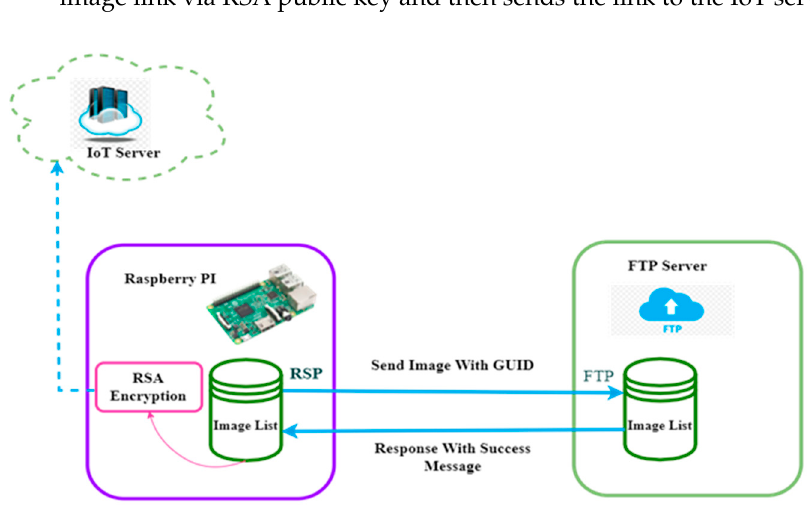
Figure 7. Image transfer process from RSPI3 to FTP.